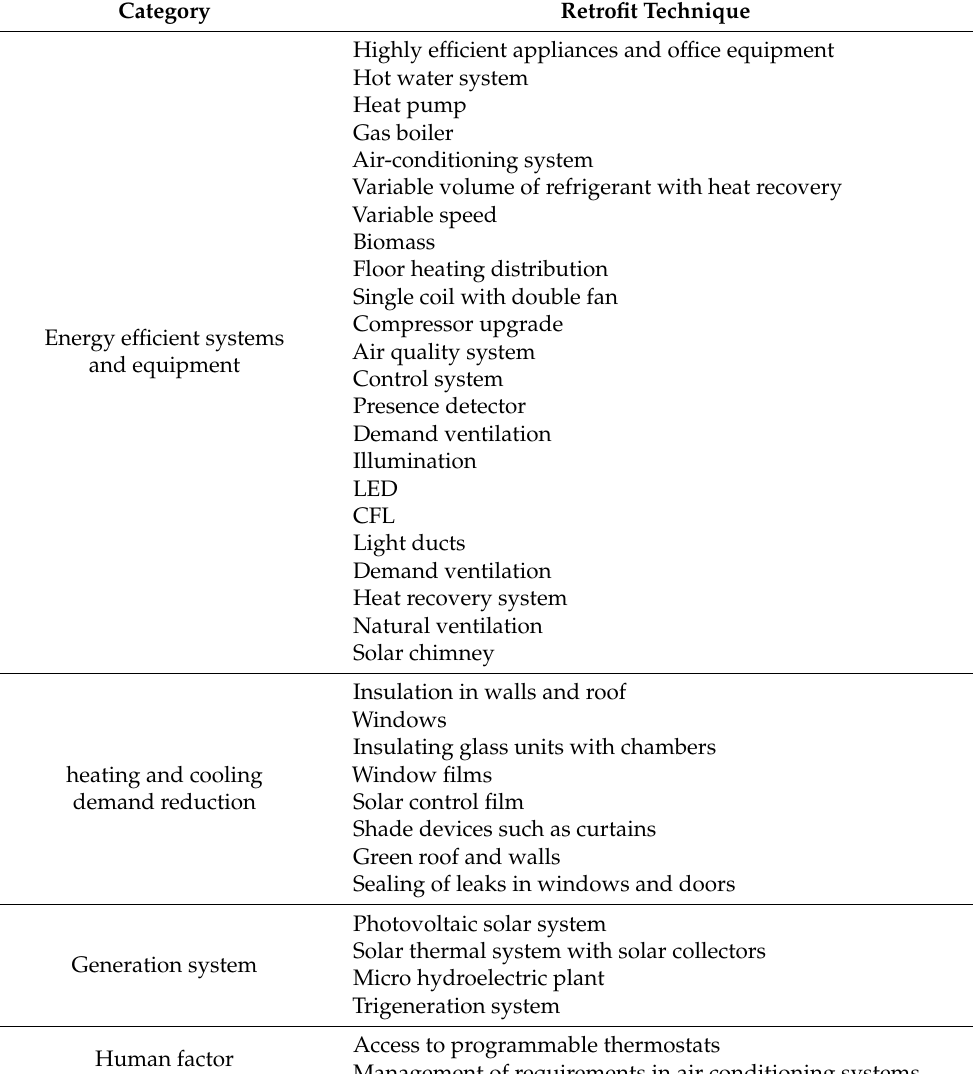
Table 3. Classification of a building according to its characteristics and the possible improvement techniques to be